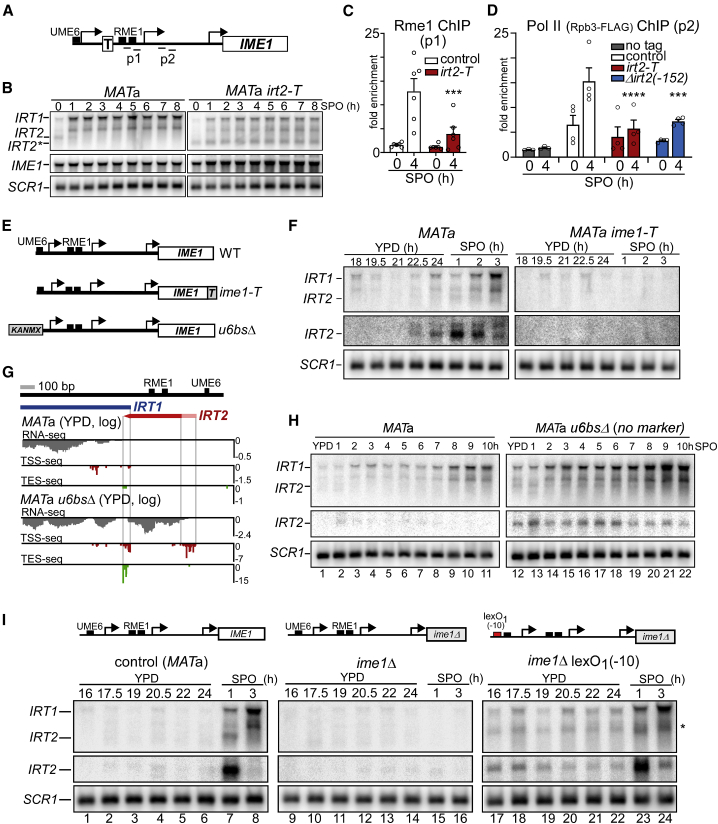
Transcription of IRT2 is required for induction of IRT1 expression(A) Scheme of IME1 promoter harboring a transcriptional terminator integrated between the IRT2 TSS and the Rme1 binding site, irt2-T. Primer pairs (p1 and p2) used for ChIP in (C) and (D) are also depicted.(B) IRT1, IRT2, and IME1 expression in WT and irt2-T MATa cells (FW1509 and FW3596). The asterisk depicts the IRT2 short form caused by early termination in IRT2.(C) Rme1 association at the IRT1 promoter in WT and irt2-T MATa cells (FW4031 and FW3128) by ChIP. qPCRs were performed using primer pair p1 depicted in (A) Error bars represent SEM; n = 6. ∗∗∗p < 0.005, two-way ANOVA followed by a Fisher’s LSD test.(D) Pol II association at IRT1 in MATa (control), irt2-T, and Δirt2(−246) (FW8515, FW8512, and FW8510, respectively) cells expressing FLAG-tagged Rpb3 along with a no-tag control (FW1509). qPCRs were performed using the primer pair p2. Error bars represent SEM; n = 4, except for the no-tag condition (n = 3). ∗∗∗p < 0.0005; ∗∗∗∗p < 0.0001, two-way ANOVA followed by a Fisher’s LSD test performed on the whole group of samples, including the one presented in Figure S2E.(E) Schemes of the ime1-T mutant, which harbors point mutations in the C terminus of IME1 (which impairs Ime1 function), and u6bsΔ, which harbors a deletion of the IRT2 Ume6 binding site.(F) IRT1 and IRT2 expression in WT and ime1-T MATa cells (FW1509 and FW2189) detected by northern blot. (G) IRT2 transcript start and end sites in u6bsΔ cells determined by TSS-seq and TES-seq during exponential growth in YPD.(H) Same as (F), except that WT cells (FW1509, lanes 1–11) and u6bsΔ MATa cells (FW2438, lanes 12–22) were used, and cells were shifted to SPO before saturation.(I) MATa WT cells (FW1509, lanes 1–8), or cells harboring ime1Δ together with the WT IRT2 promoter (FW1555, lanes 9–16) or a lexO1(−10) site (FW7142, lanes 17–24) were grown as in (F), and samples were taken at the indicated time points. Asterisk indicates a longer version of IRT2 originated from lexO1(−10) that has about the same size of one IRT1 isoform.